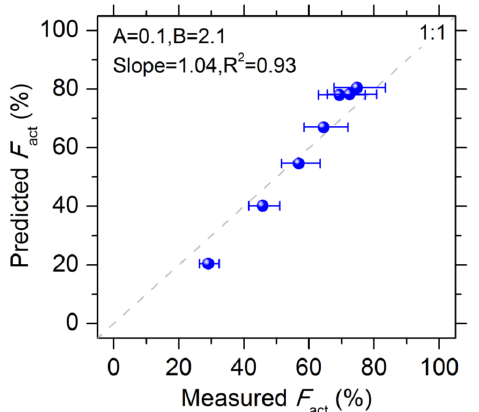
Figure 7. Comparison of measured activation fractions for 2.5nm ammonium sulfate particles with those predicted from the modified Köhler equation including the FHH adsorption isotherm (Eq. 10 in the text). The whisker represents the standard deviation caused by the electrometer counting.